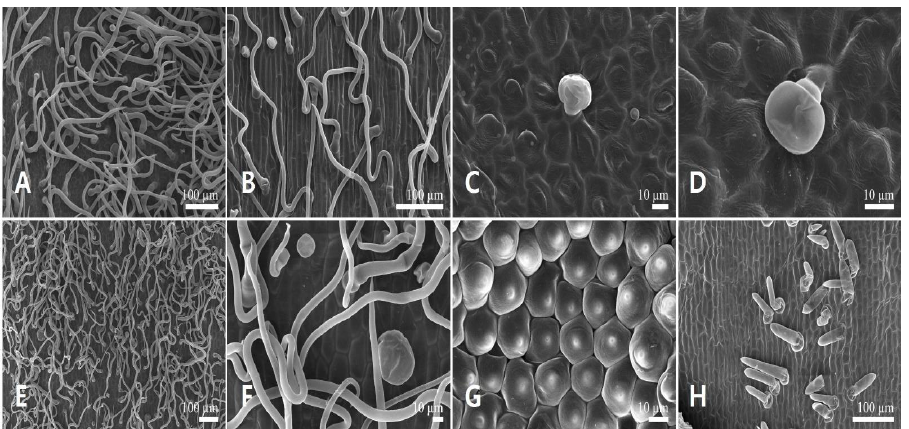
indicate the stomata.